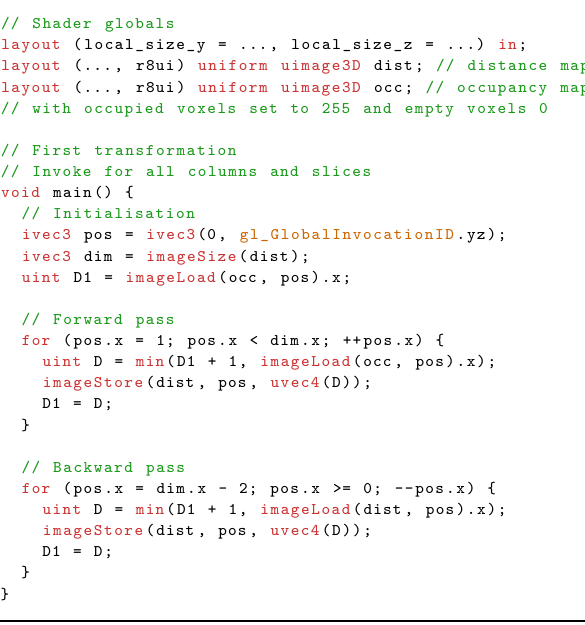
Algorithm 2 The first of the occupancy map to Chebyshev distance map transformations